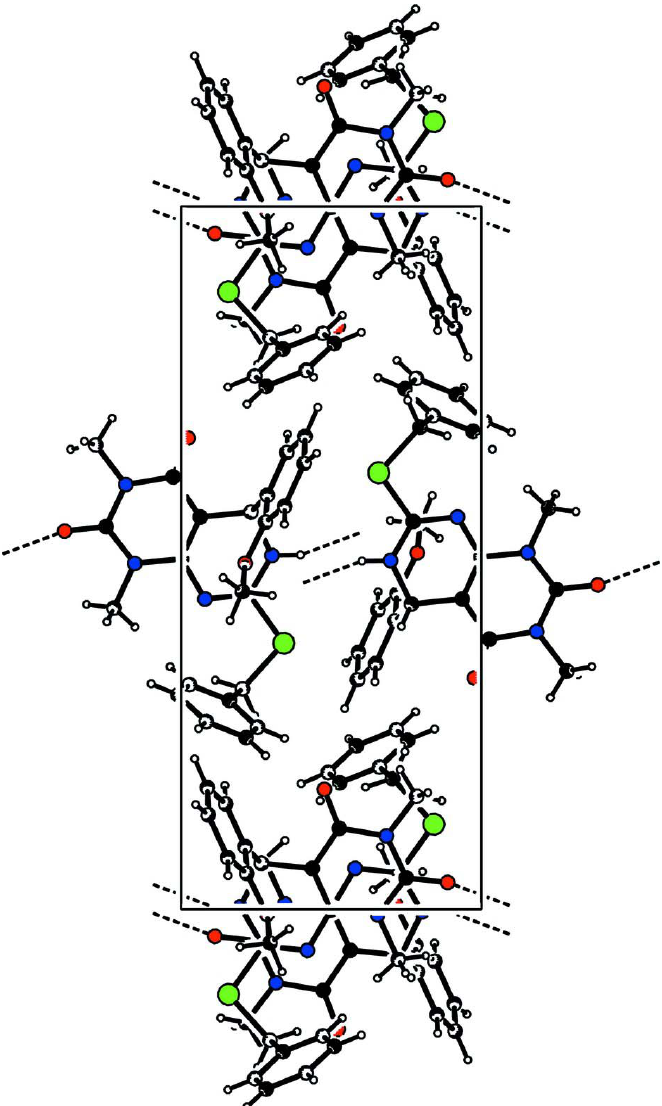
A packing diagram of the title compound. Hydrogen bonds are shown as dashed